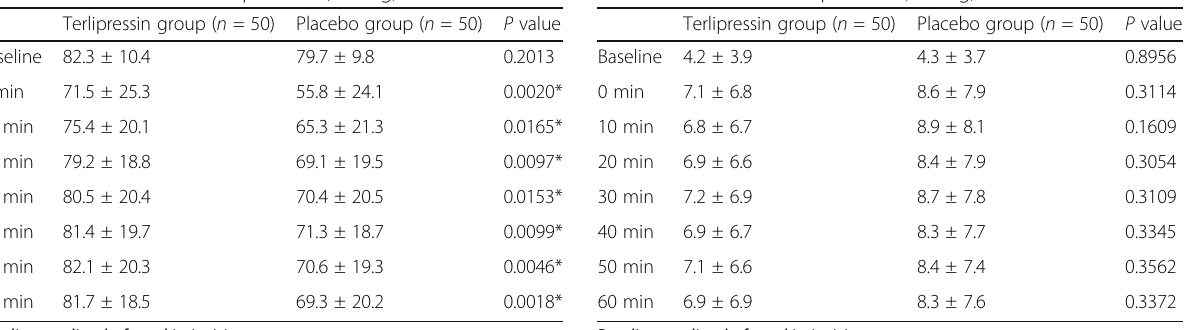
Table 5 Central venous pressure